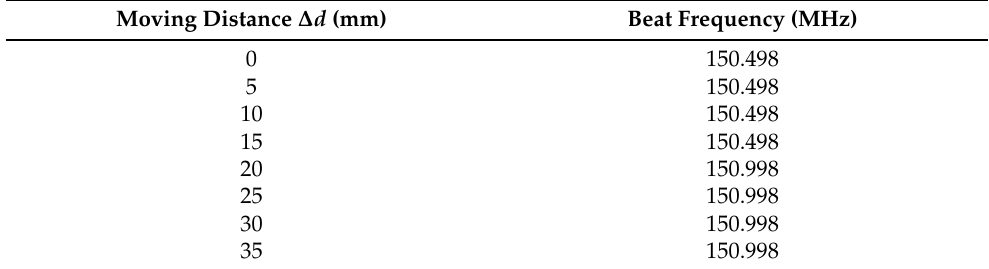
Figure 7. Power spectrum of de-chirped signal under T = 2 µ s and different moving distance ∆ d . RBW: 1 kHz, and VBW: 1 kHz. Table 1. The beat frequency corresponding to the spectral peak under different moving difference ∆ d